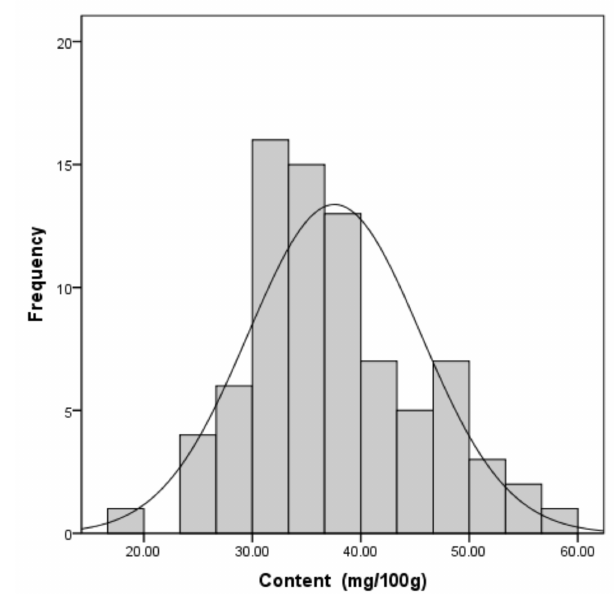
Figure 3. The stem-and-leaf plot of normal distribution